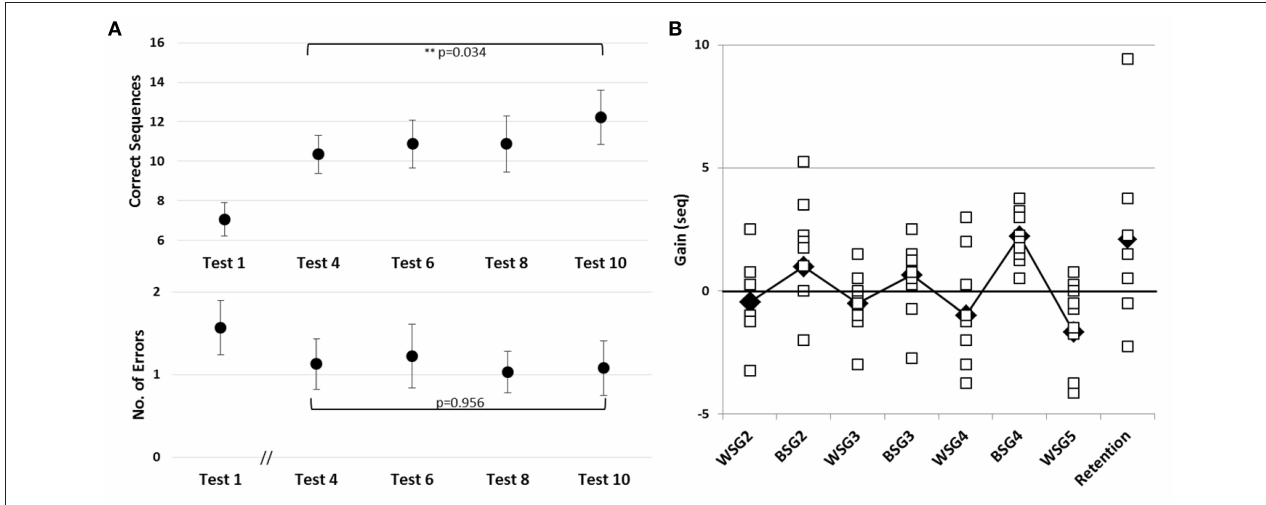
FIGURE 4 | Learning across the four training sessions of the second week of intervention and performance at retention. (A) Pre-tests of Sessions 2–5 are shown. Performance at Session 1 (Test 1) is presented as a reference point for improvements during the second week (Tests 4, 6, 8, and 10). Upper and Lower panels–as in Figure 3 . (B) Individual within-session gains, WSG 2-5, and between-session gains, BSG 2-4 are shown, calculated as in Figure 2B . Black diamonds–group means; Retention–mean and individual gains relative to Test 12 ( N = 7).